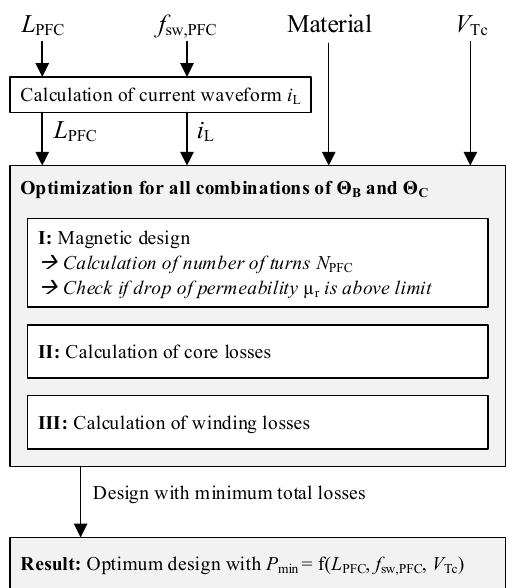
Figure 6. Flowchart describing the optimization strategy for the PFC inductance. Using the definitions in [41,42], the length of the magnetic path l e,Tc , the magnetic cross- section A e,Tc , and the necessary number of turns N PFC to obtain the selected inductance L PFC can be calculated